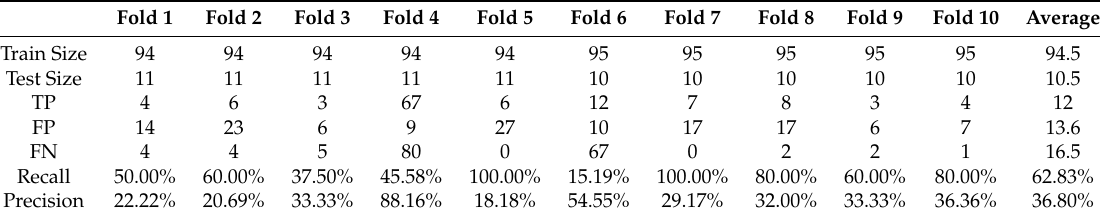
Table A6. The Results of Experiment 6: Augment the complete dataset containing images with and without dents (Dataset 6).